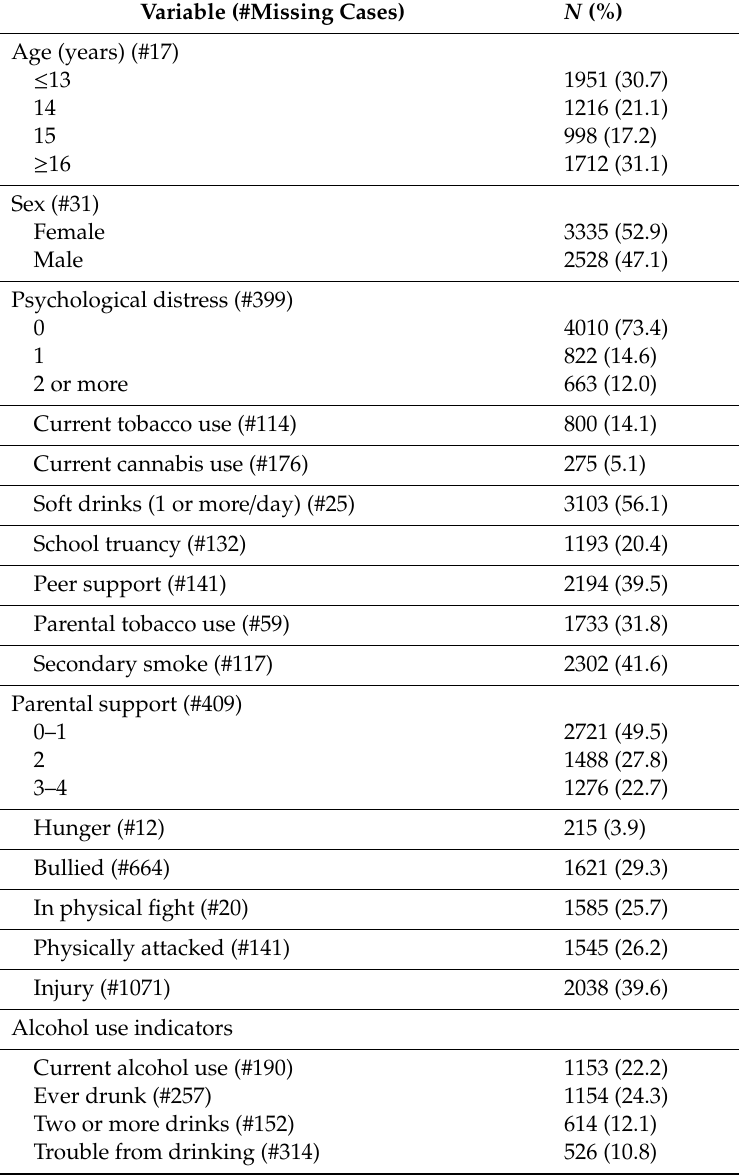
Table 2. Sample characteristics of adolescents in Thailand, GSHS, 2015 ( N =